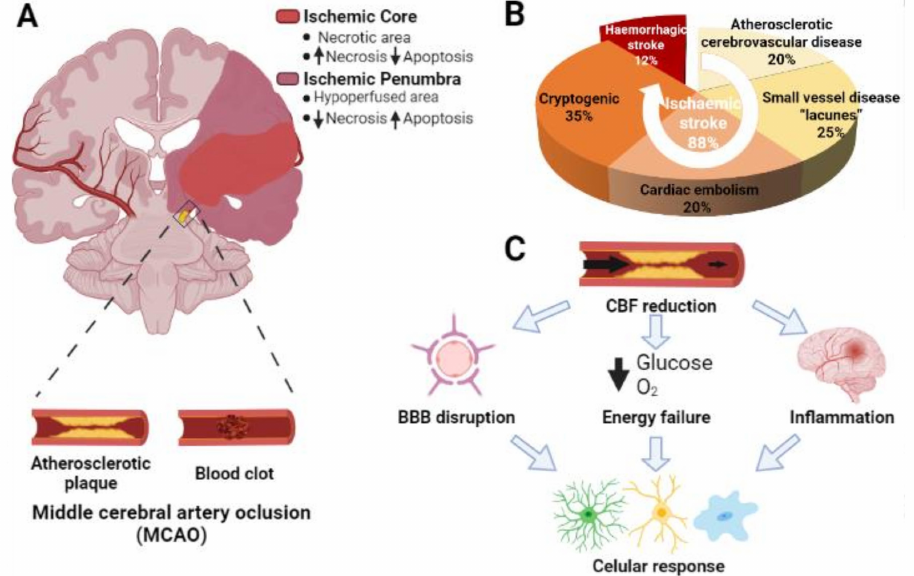
Figure 1. Main characteristics of the ischemic stroke. ( A ) Graphic representation of a coronal section of an adult human brain, which highlights the middle cerebral artery occlusion and its main causes: a blood clot and the formation of an arterosclerotic plaque. The ischemic core is highlighted in red and the penumbra region in fuchsia. ( B ) Epidemiological data of the incidence of the two main types of stroke (hemorrhagic and ischemic) and the main causes that lead to ischemic stroke. ( C ) Schematic representation of the main pathophysiological events triggered upon